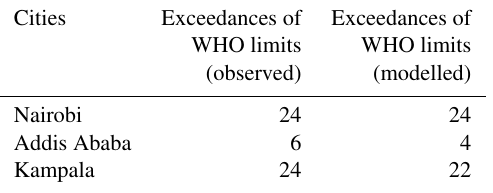
Table 6. Summary of the number of observed and modelled PM 2 . 5 exceedances of the WHO limits during the simulated period from 14 February to 14 March 2017. Cities Exceedances of Exceedances of WHO limits WHO limits (observed) (modelled) Nairobi 24 24 Addis Ababa 6 4 24